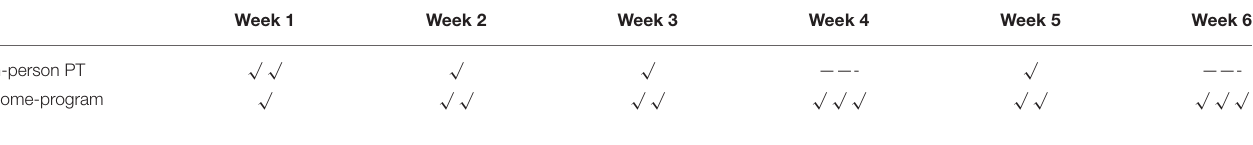
TABLE 1 | Timeline of the intervention